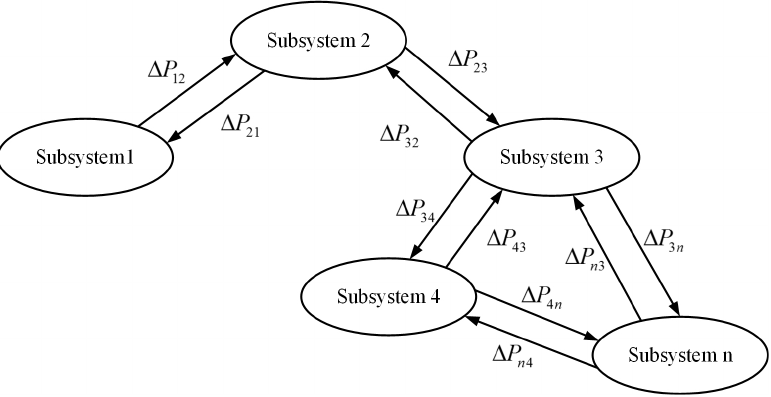
Figure 1. Power grid